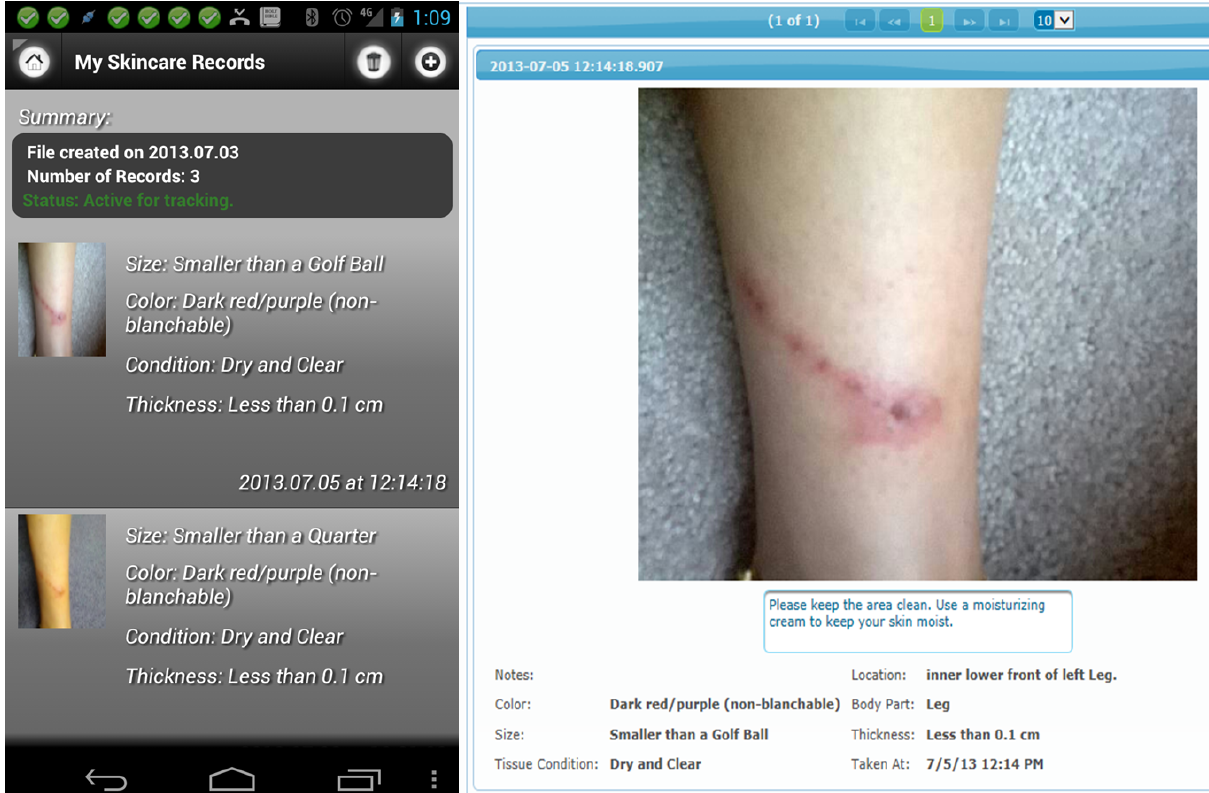
Figure 4. Skincare app and portal side by